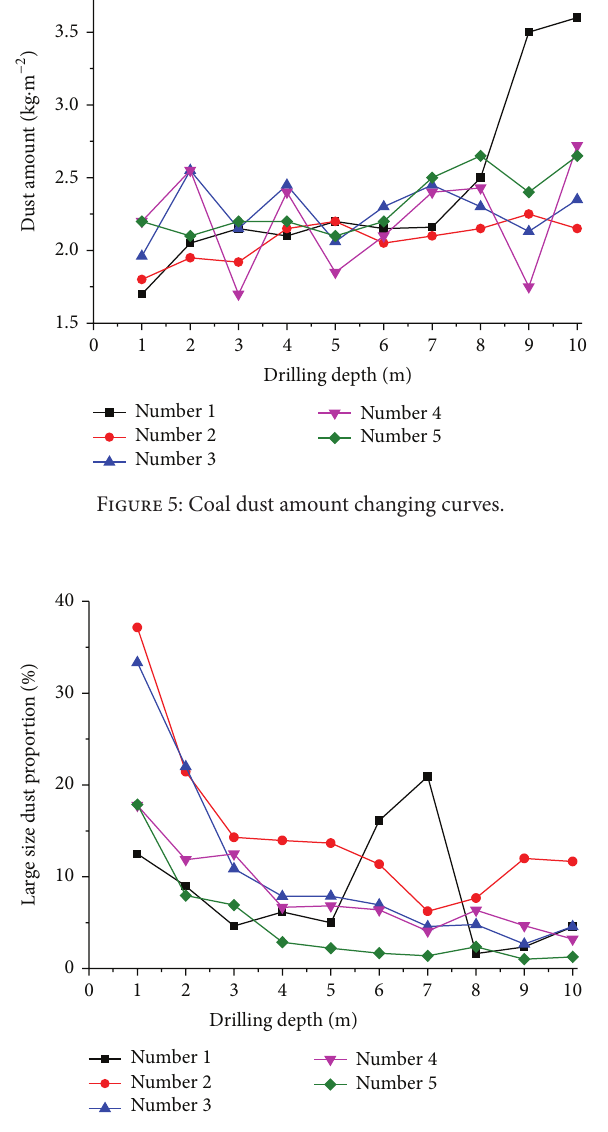
Figure 6: Large size dust proportion changing curves.